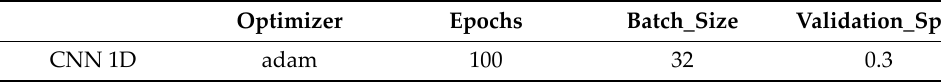
Figure 3. Text-based CNN 1D preprocessing. Table 5. Settings of CNN 1D model. Table 5. Settings of CNN 1D model.